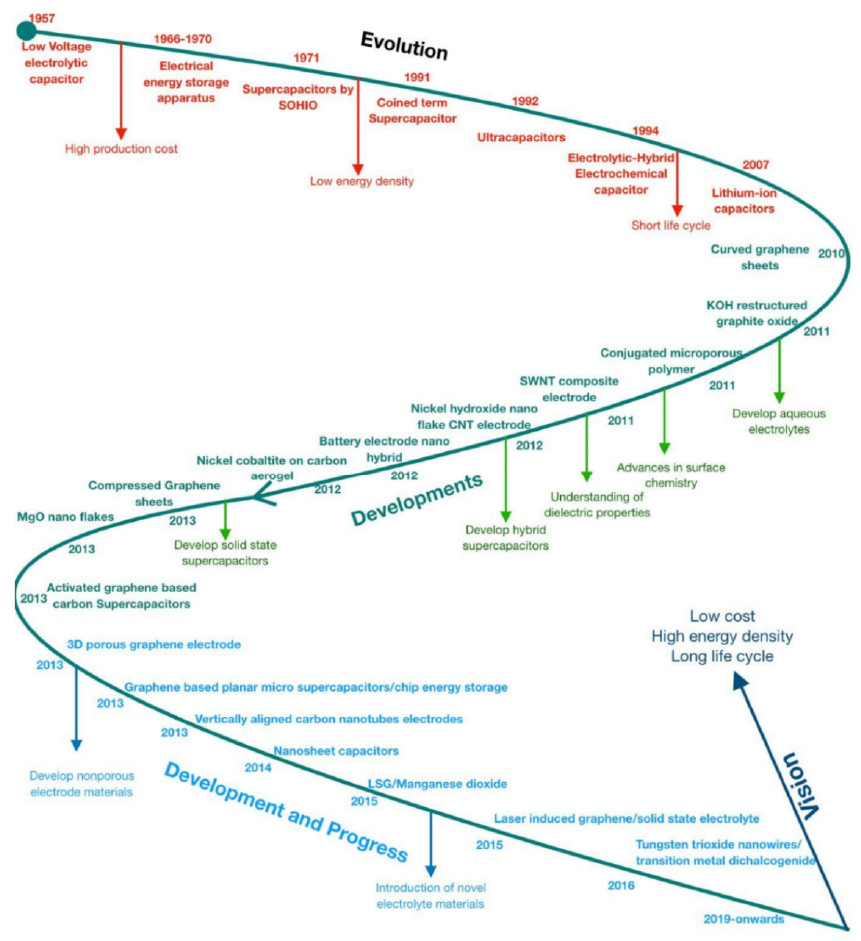
Figure 13. Roadmap of the evolution, progress, and developments of supercapacitors. Reproduced with permission from [126].